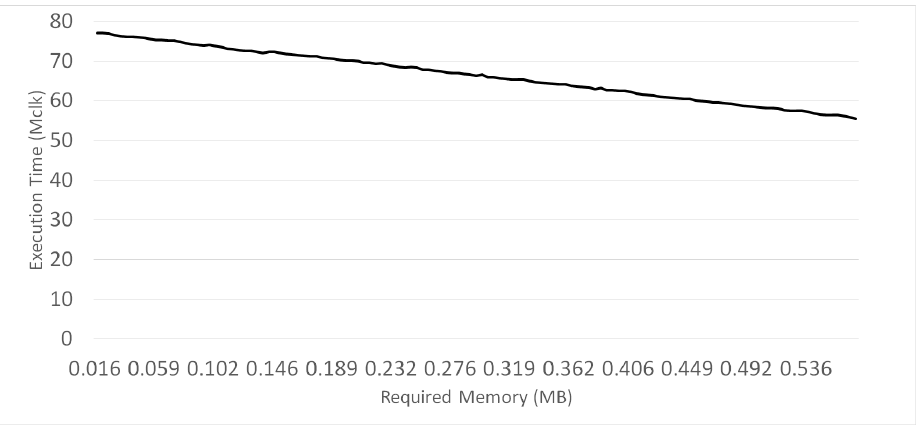
Figure 4. Time-memory trade-off of the adaptive